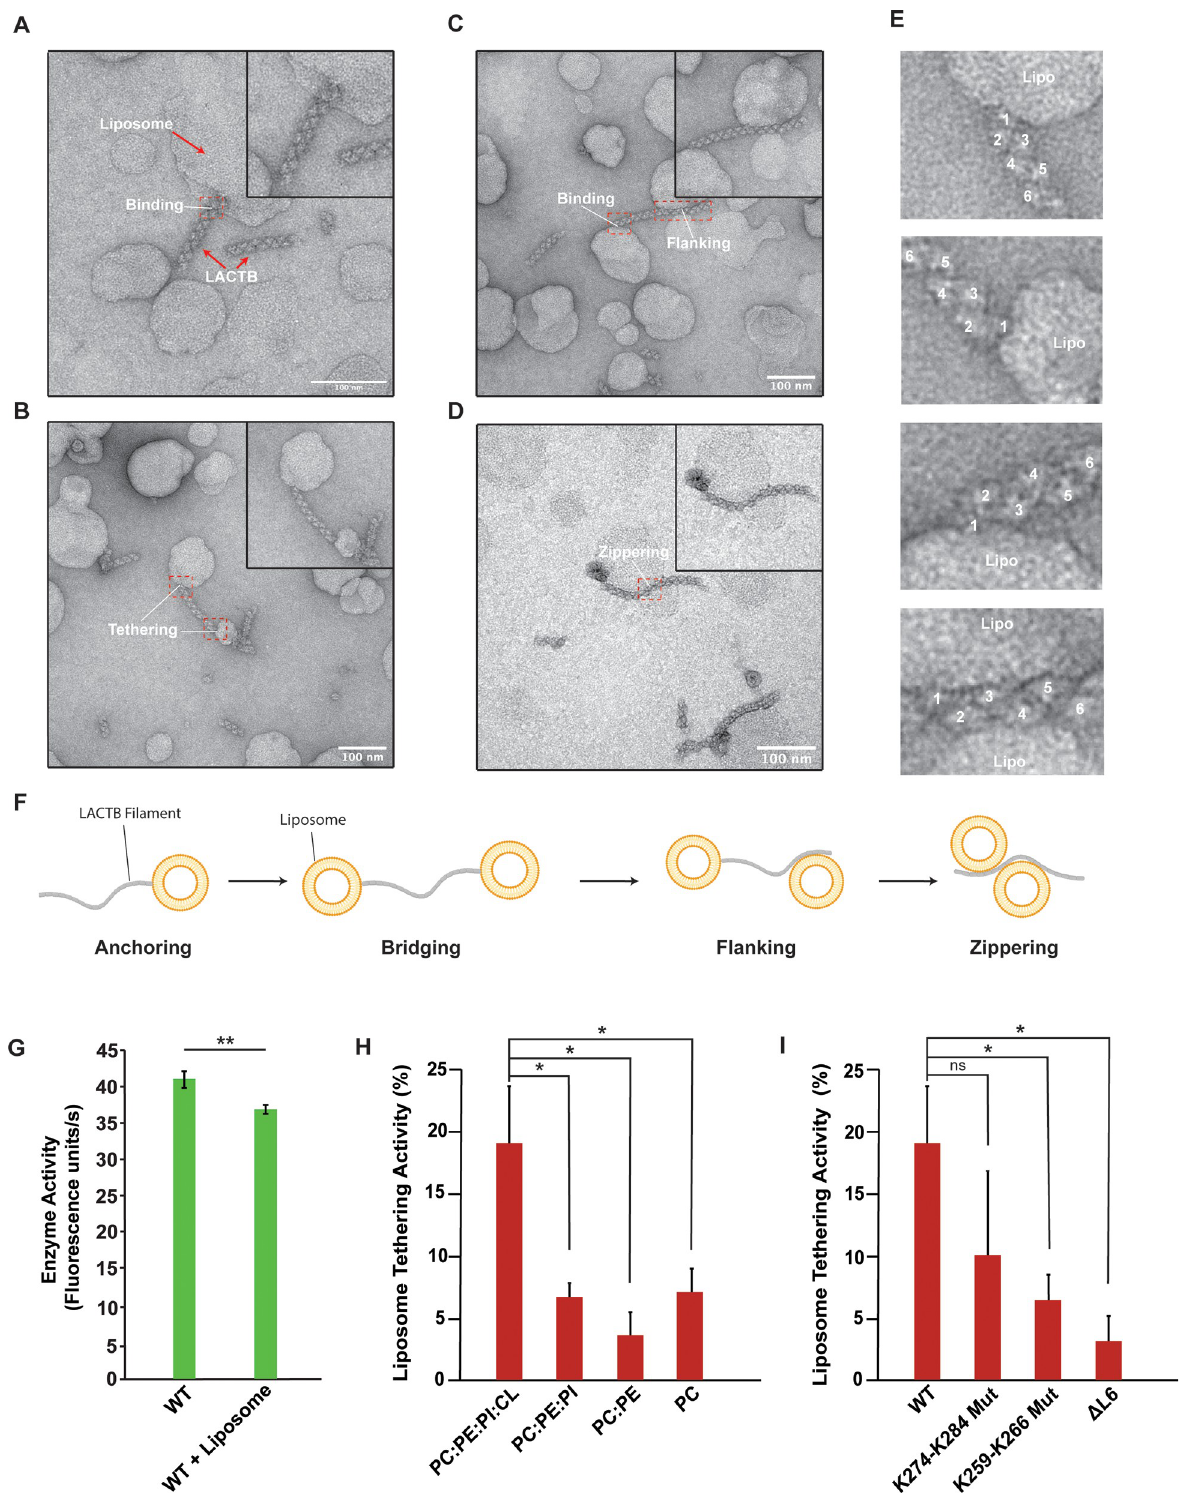
Fig 5. LACTB filaments bind to CL-enriched liposomes. ( A–D ) Representative negative-stain TEM images of LACTB filaments in the presence of liposomes. Scale bar, 100 nm. Purified LACTB filaments were incubated with CL-containing liposomes at room temperature for 4 h. Red boxes indicate protein–membrane contact sites. ( E ) Zoomed in views of the red boxes in ( A – D ), showing the details of protein–liposome interactions. ( F